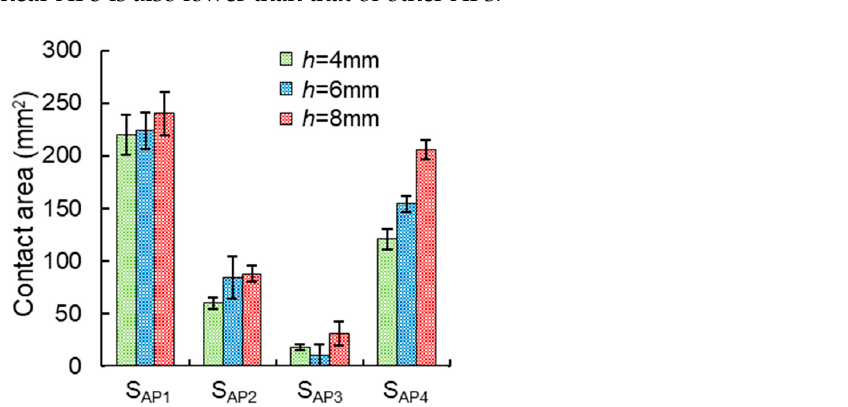
Figure 6. The experimental results of the contact area of four APs ( S AP1 ~ S AP4 ) during the adhesion stage of three